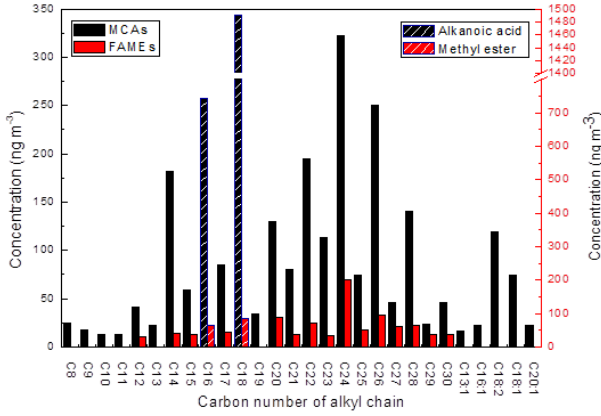
Figure 3. Mean monocarboxylic acids (MCAs) and fatty acid methyl esters (FAMEs) concentrations in PM 2 . 5 samples collected in January 2013 in